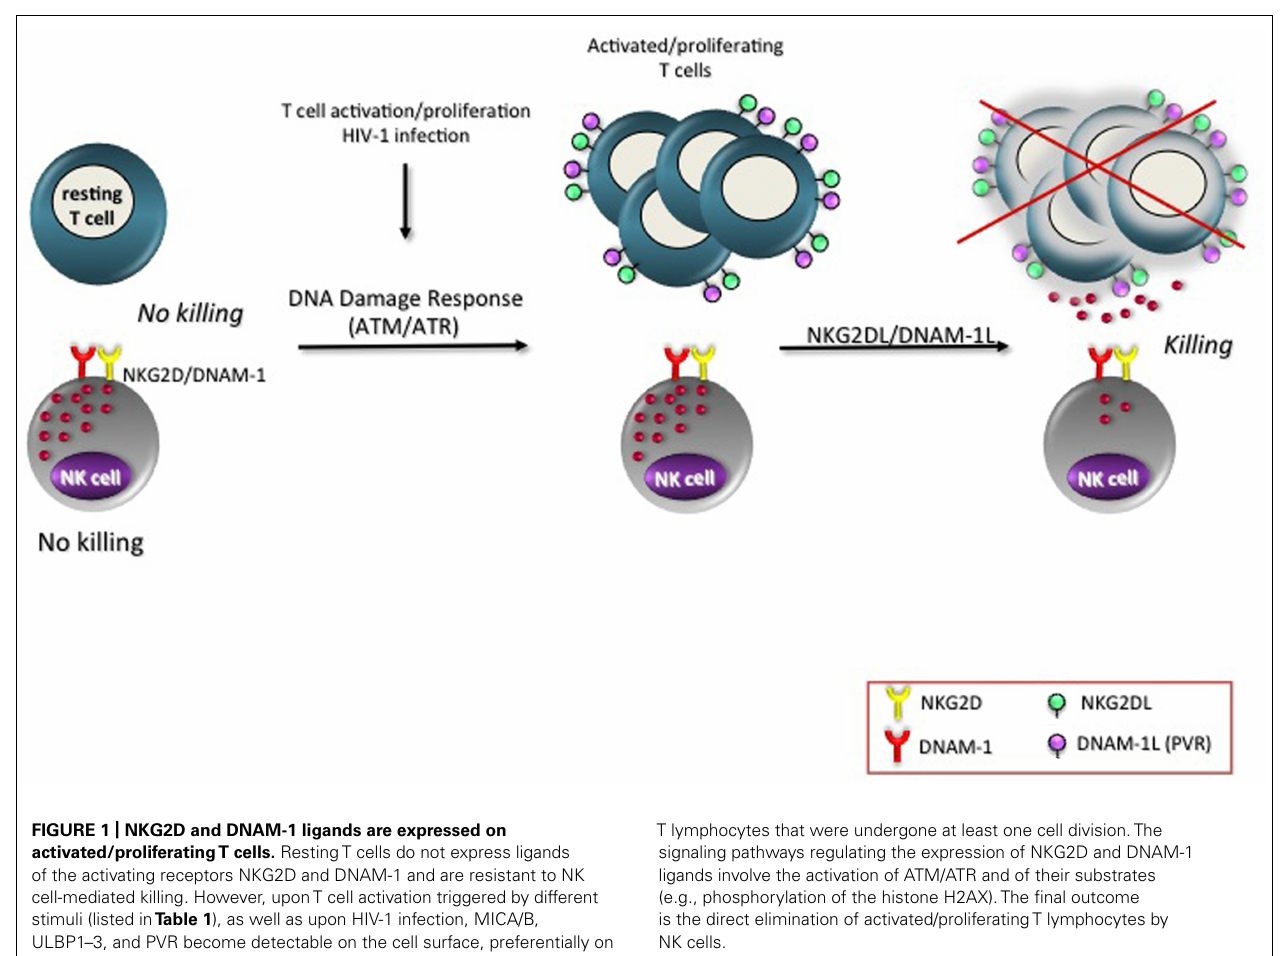
FIGURE 1 | NKG2D and DNAM-1 ligands are expressed on activated/proliferatingT cells. RestingT cells do not express ligands of the activating receptors NKG2D and DNAM-1 and are resistant to NK cell-mediated killing. However, uponT cell activation triggered by different stimuli (listed in Table 1 ), as well as upon HIV-1 infection, MICA/B, ULBP1–3, and PVR become detectable on the cell surface, preferentially on